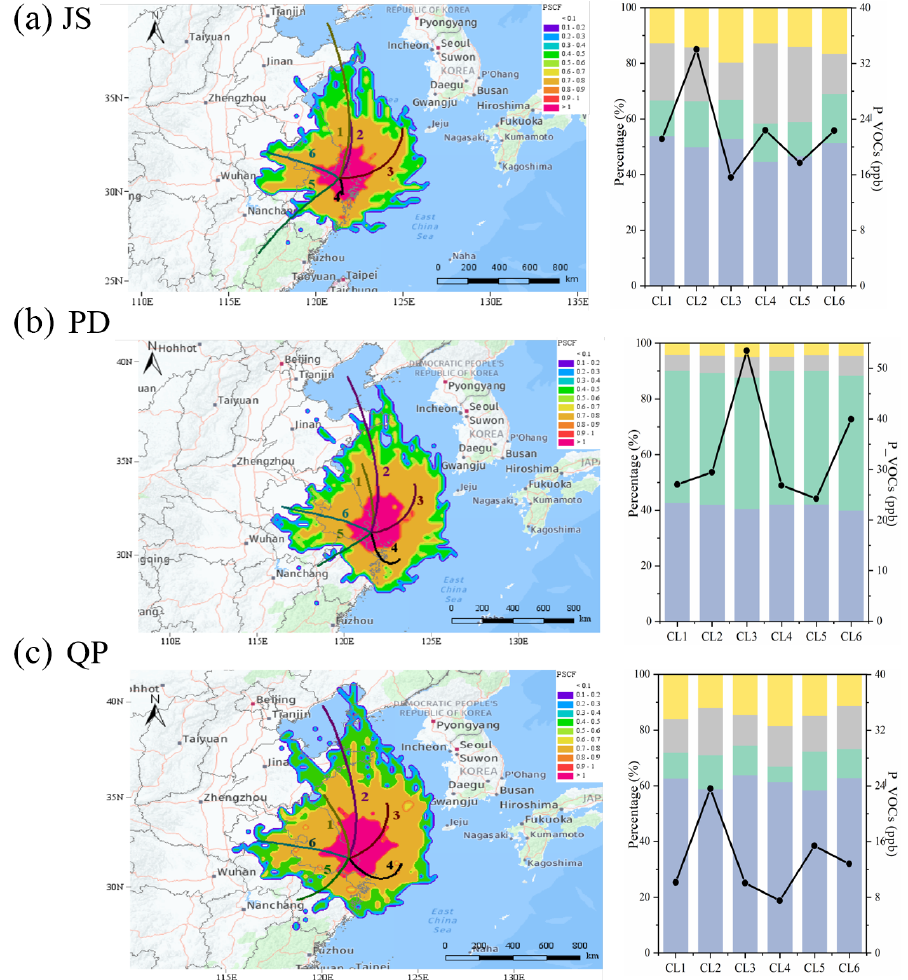
Figure 7. Backward-trajectory cluster analysis (24h) and PSCF analysis at the JS, PD and QP sites.